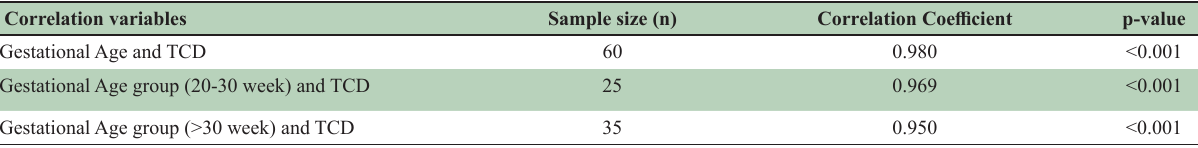
Table-II: Correlation between TCD and Gestational